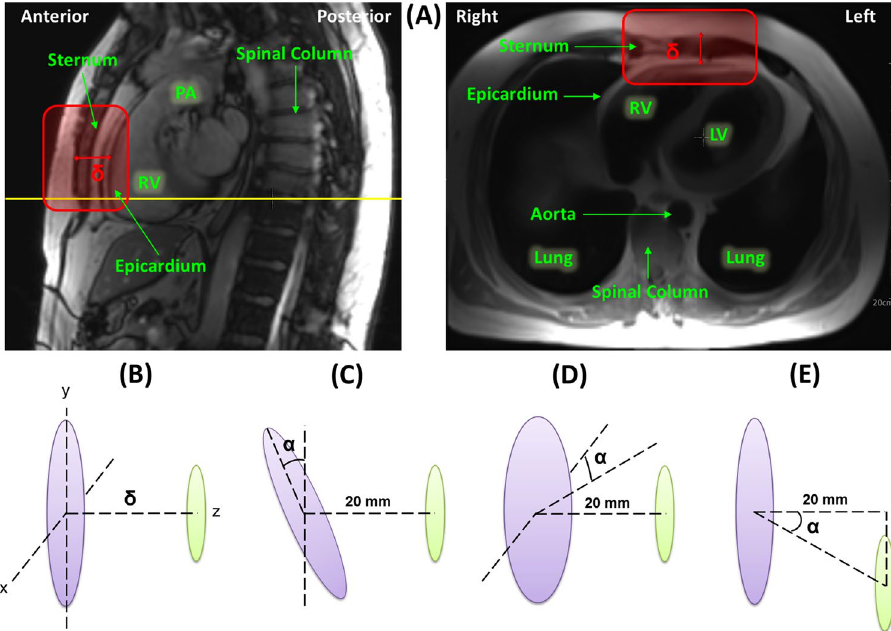
Figure 3. Determining Range of Function. ( A ) Thoracic MR images in which the left image shows the sagittal view with the yellow line representing the cross-reference line for the axial black blood image in right image. The red box represents the region in which measurements were made in both views. The distance, δ , represents the displacement measured along the region of the red box in which the receiver will be located in the anterior cardiac vein and the transmitter will be located in the anterior chest wall below the adipose tissue along the sternal border. PA: pulmonary artery, RV: right ventricle, LA: left ventricle. ( B ) Antenna assessment at distance, δ , ( C ) Antenna assessment with x-axis angular misalignment at angle, α , ( D ) Antenna assessment with y-axis angular misalignment at angle, α , and ( E ) Antenna assessment with displacement misalignment at angle, α .